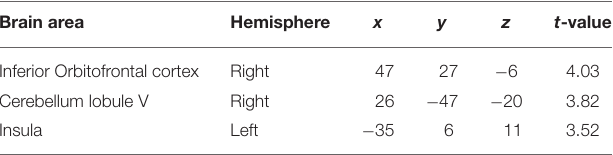
Table 2B | Brain areas whose activity decreased as a function of memory load.